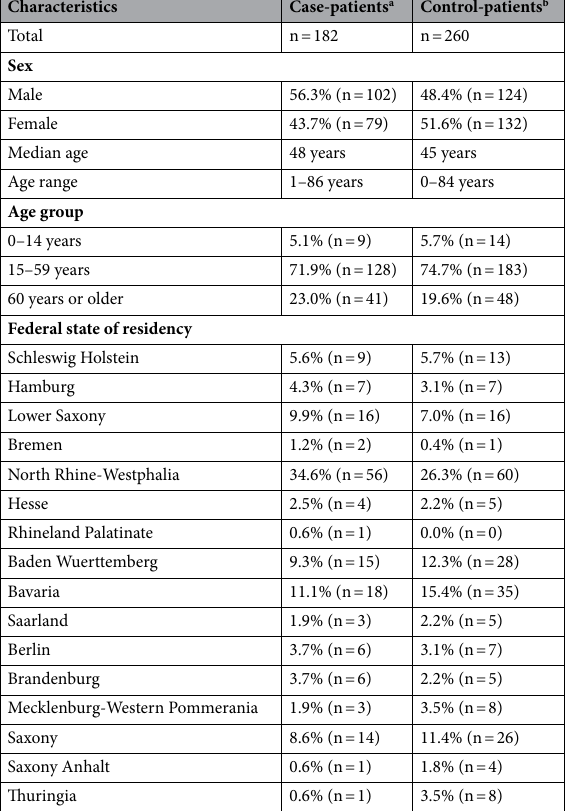
Table 1. Characteristics of case–control study participants; Campylobacter enteritis winter peak, Germany 2018/2019. a Case-patients: Campylobacter enteritis cases with disease onset between 25 December 2018 and 8 January 2019. b Control-patients: Campylobacter enteritis cases with disease onset between 30 November and 24 December 2018, or between 9 January and 28 February